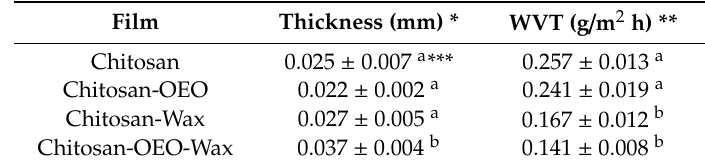
Table 2. Thickness and WVT of edible films constituted by chitosan, OEO, and carnauba wax at 25 ◦ C.